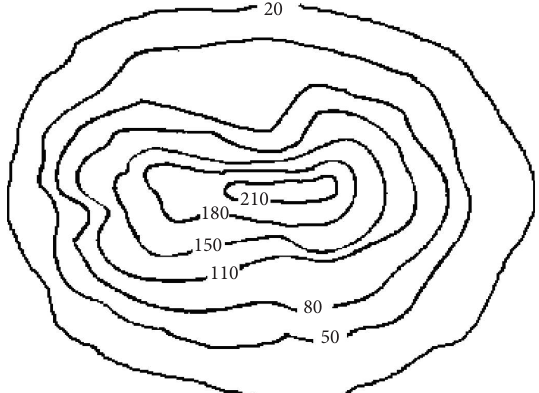
Figure 2: A papery contour